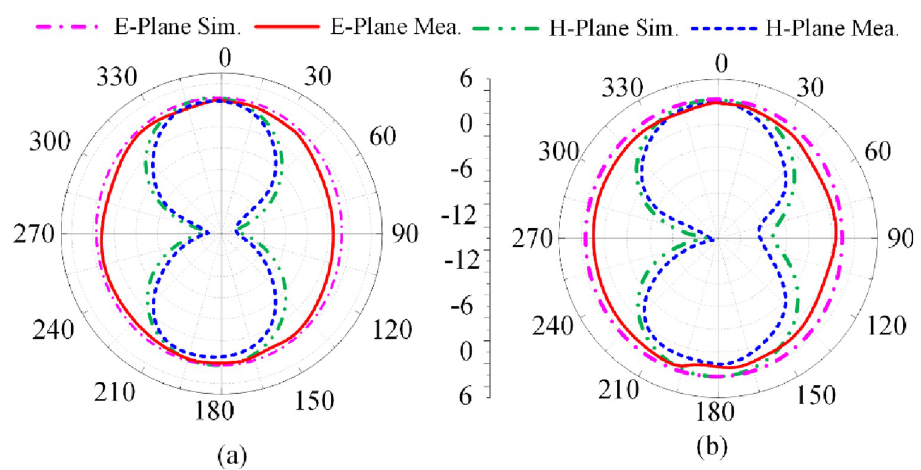
Fig 8. Radiation pattern of proposed antenna when PIN diode D1 is reverse biased and D2 is forward biased at (a) 2.4 GHz, and (b) 4.1 GHz.